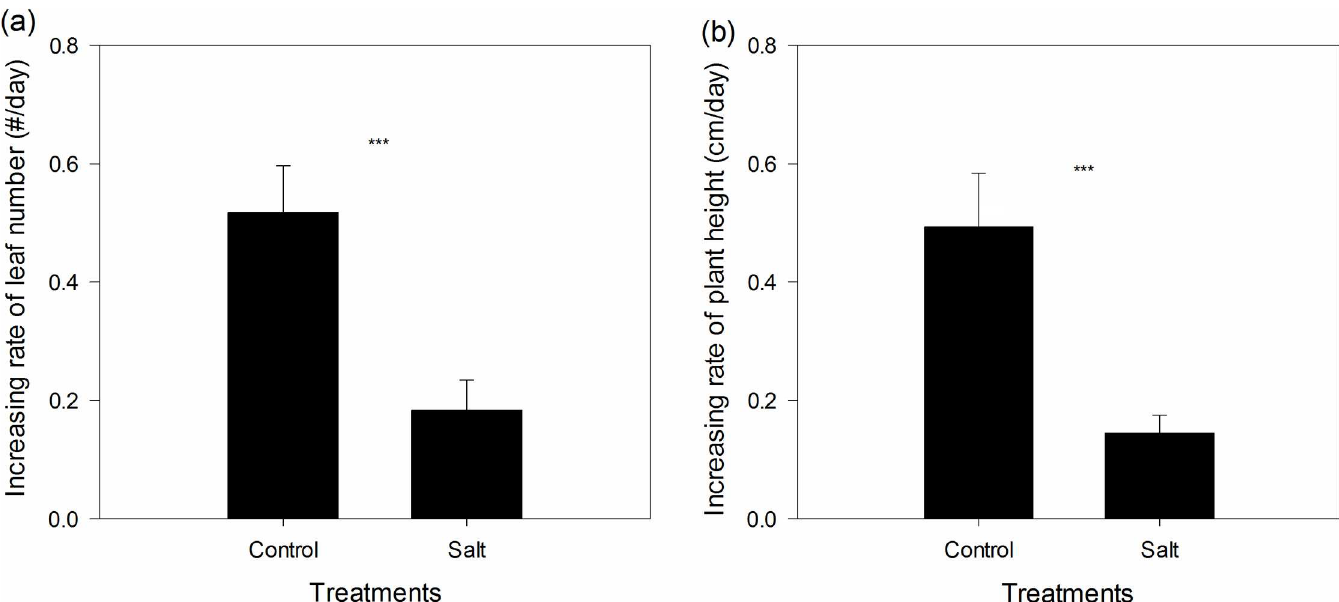
Fig 1. Effect of salt treatment on the rate of increasein the number of leaves (a) and plant height (b). Values are shown in mean ± standarderror (SE). *** , indicatesthat the difference between the control and the salt treatment is significantat p < 0.001.